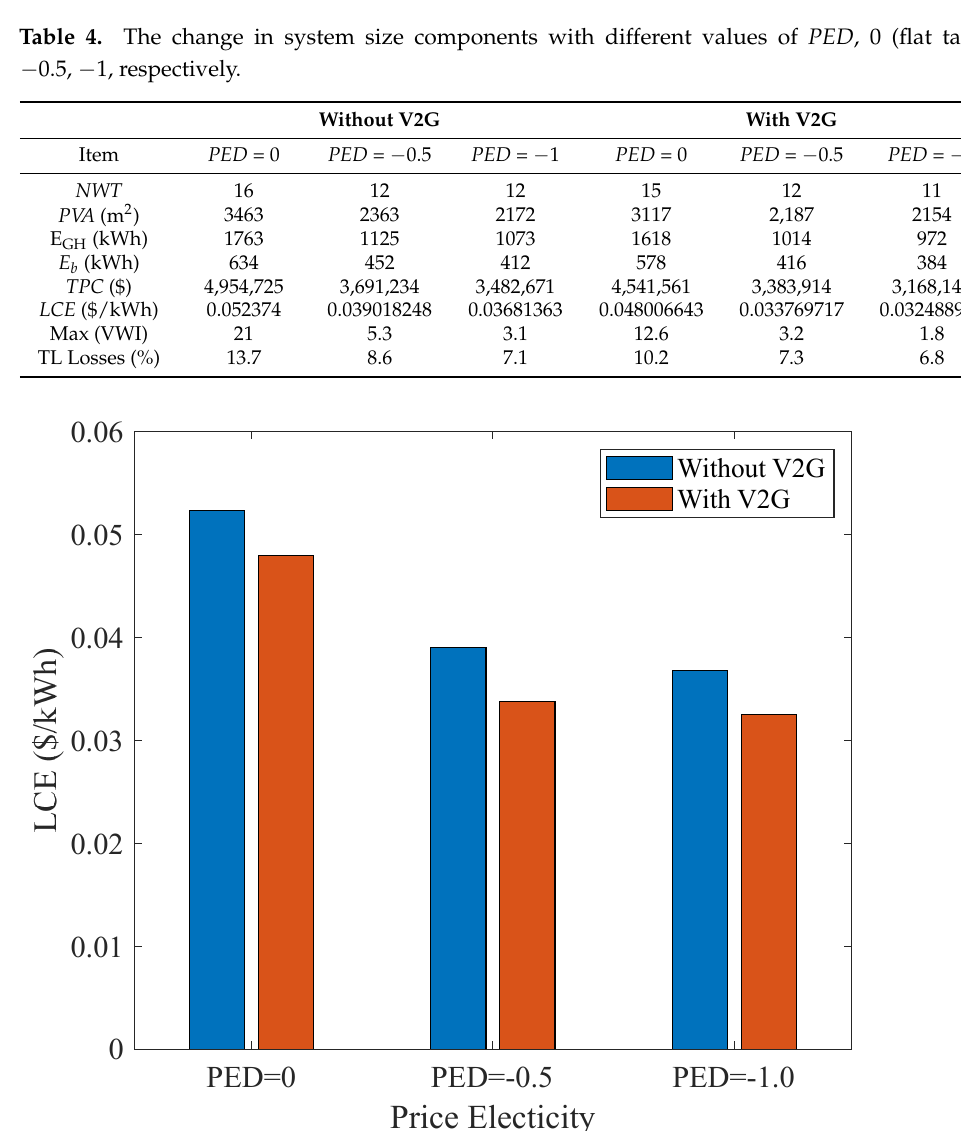
Figure 10. The LCE for different values of PED with and without V2G.